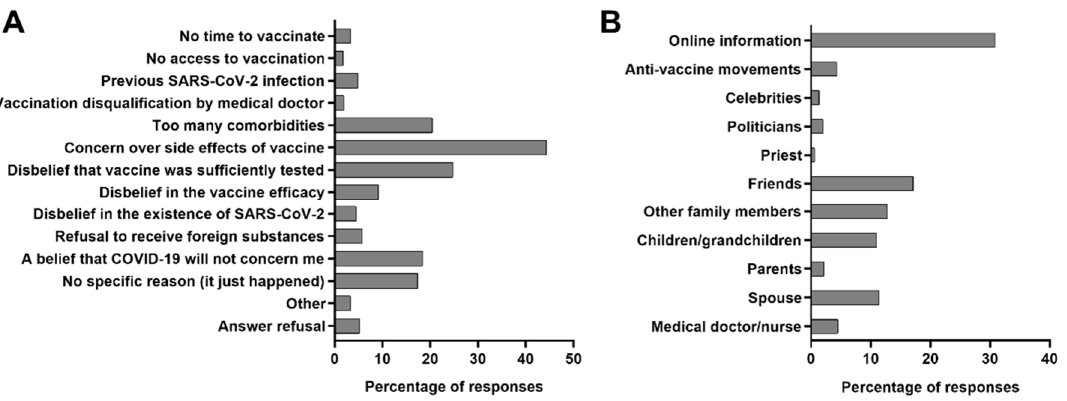
Figure 1. The frequency of reasons behind the refusal to receive the vaccine ( A ) in the whole studied group of patients hospitalized due to COVID-19 in Poland ( n = 730), and ( B ) those whose decisions were made under the influence of opinions of other people or organizations ( n = 377).